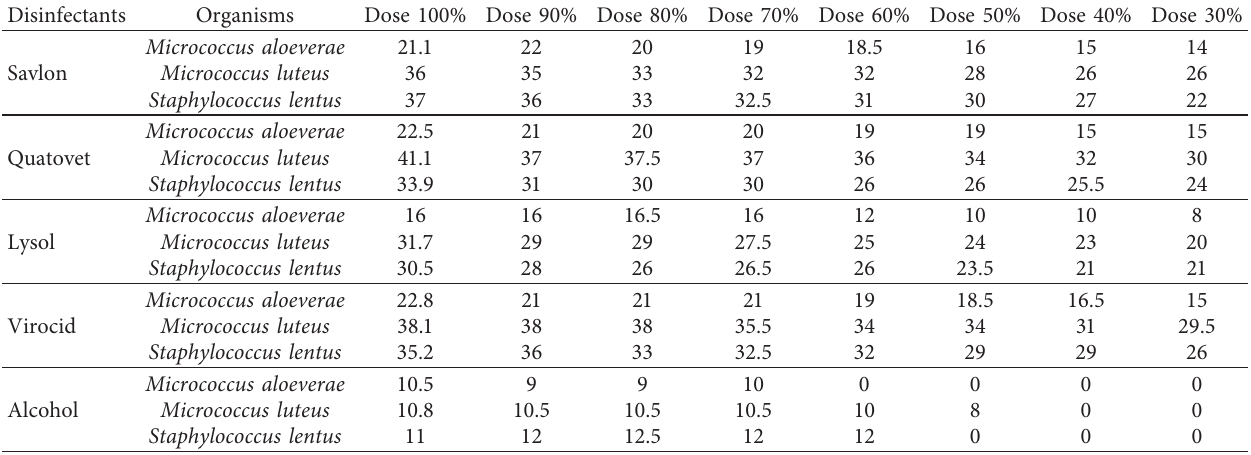
Table 3: Average diameter of the inhibition zones at different concentrations of the disinfectants tested against Staphylococcus lentus and Micrococcus spp.